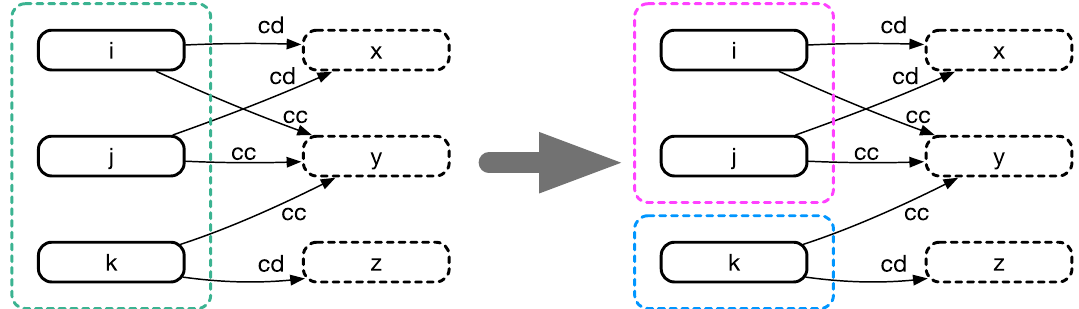
Figure 2. DFA minimization. Nodes i , j , and k should be split into two sets, { i , j } and { k } , because i and j lead to the same future via either cc or cd , whereas k responds differently.